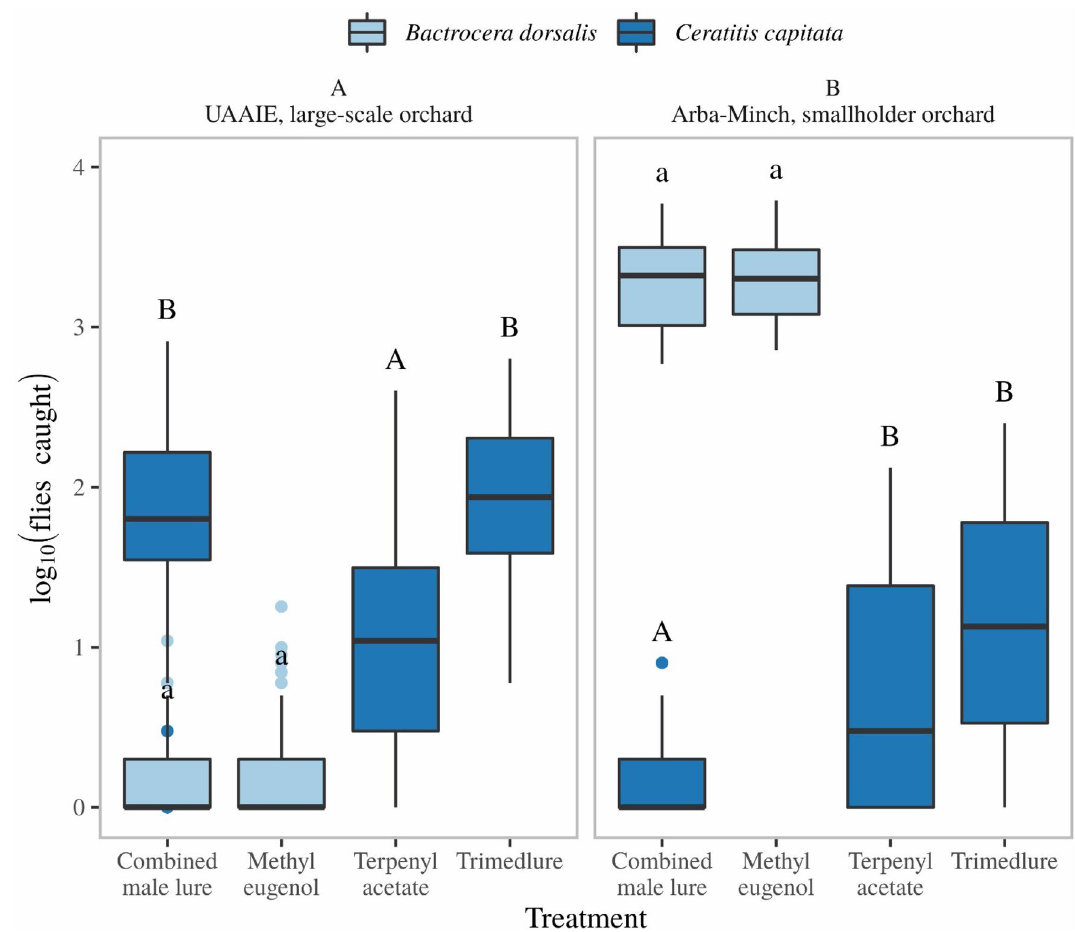
Figure 7. Comparison of catches of B. dorsalis and C. capitata with lures baited with different male attractants in both large-scale commercial orchards (UAAIE, A), and smallholder orchards (Arba-Minch, B). Statistics were performed using a generalized linear mixed model using a negative binomial distribution and by taking the variable “week” as random effect. Capital and lower-case letters are used to show statistically significant differences for different species, capital letters are used for C. capitata and small letters are used for B. dorsalis